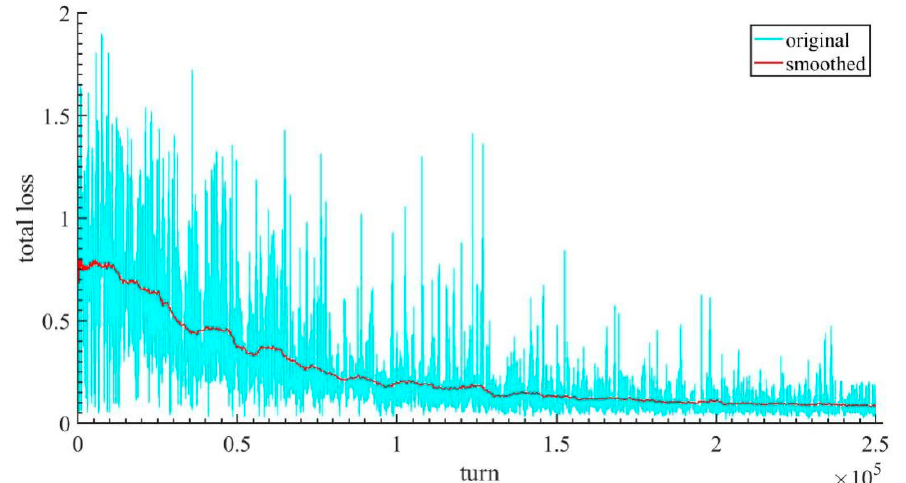
Figure 7. Total loss of the GW location model. The blue line is the original value, drastically fluctuating due to the random processes in the training. The red line is the smoothed value obtained by a smooth window with width of 100, showing the changing trend of the total loss. After 250,000 rounds of training, the total loss decreased to lower than 0.1.